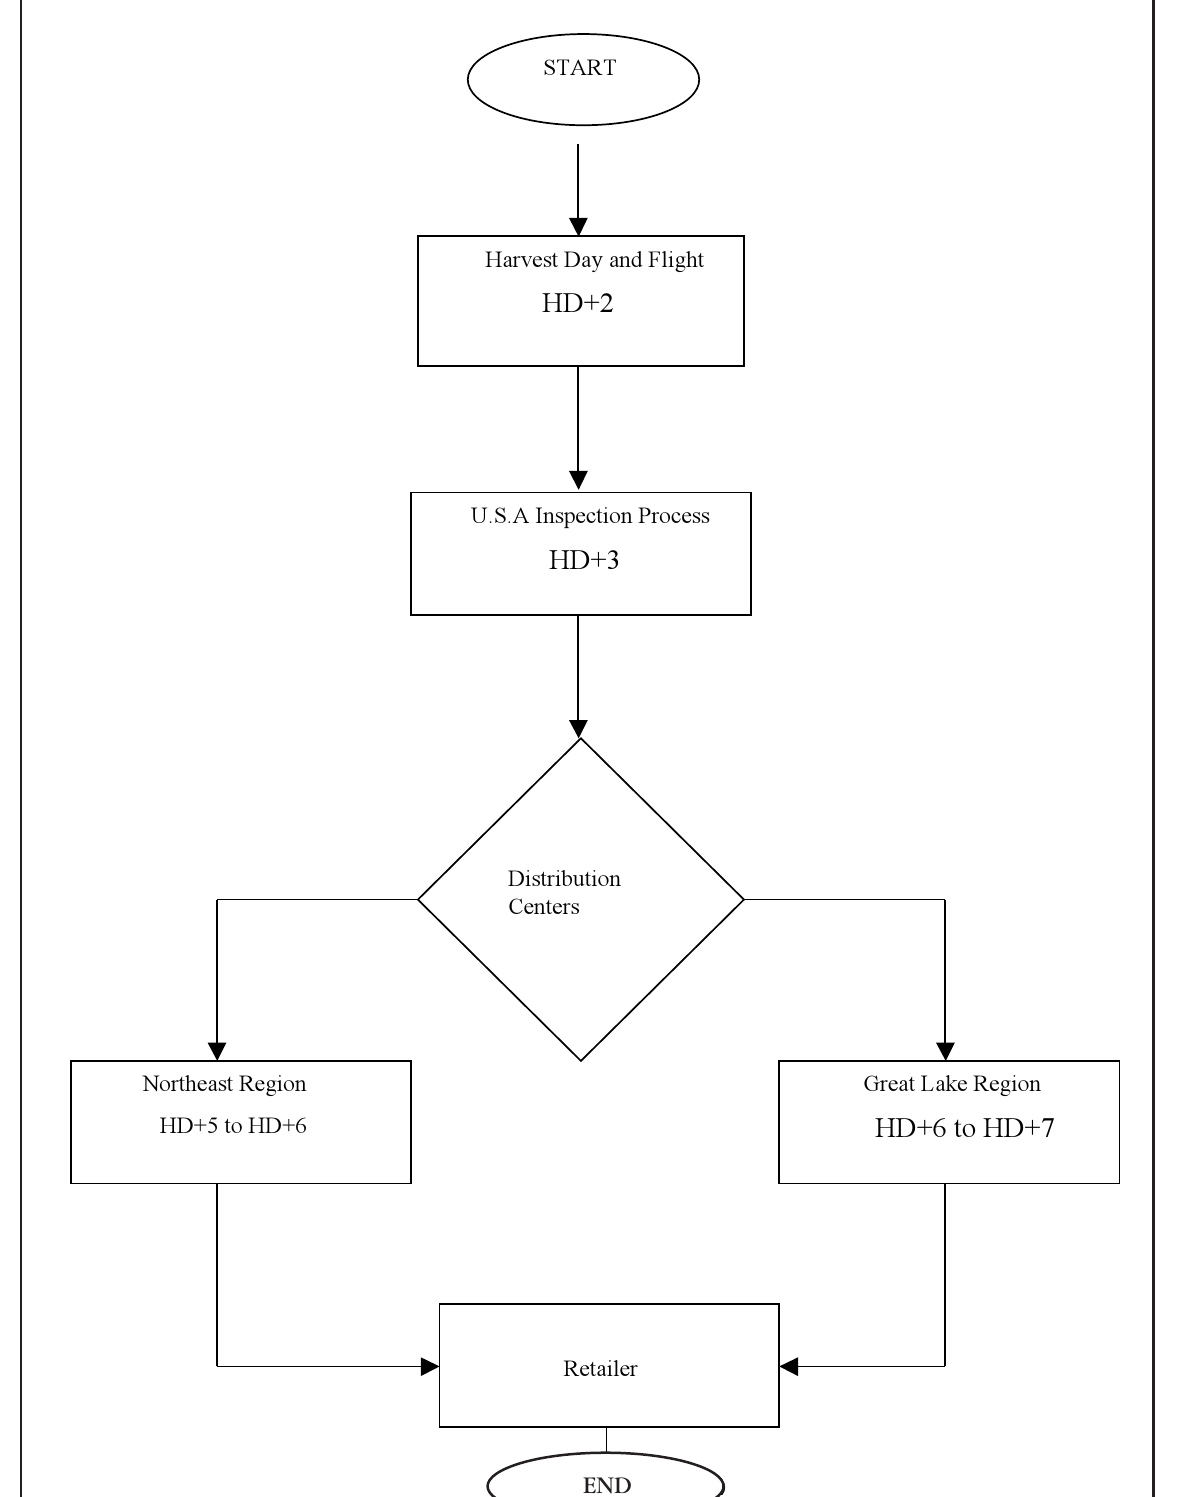
Figure 3. U.S. Distribution